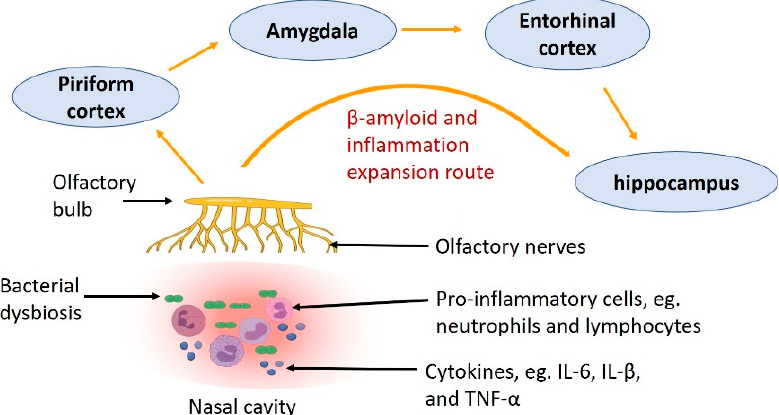
Figure 2. The route showing how inflammation caused by nasal bacterial dysbiosis and A β deposition in the olfactory nerve in CRS spread to other parts of the central nervous system, through the olfactory bulb to the piriform cortex, amygdala, entorhinal cortex and hippocampus.